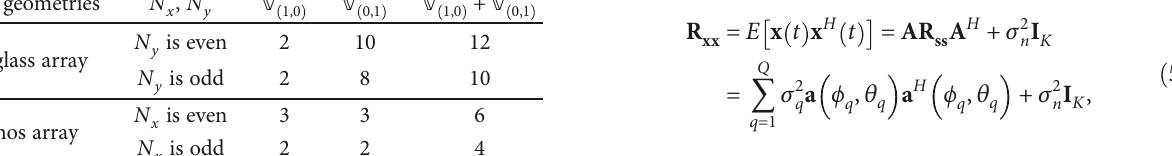
Table 1: Crucial weight comparison of two array geometries. Array geometries Hourglass